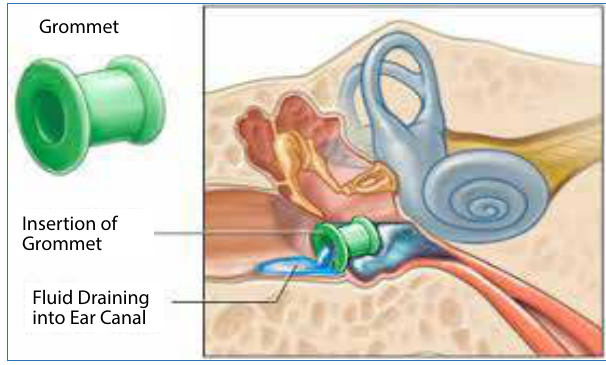
in-situGrommet Insertion of Grommet Fluid Draining into Ear Figure 1: Grommet